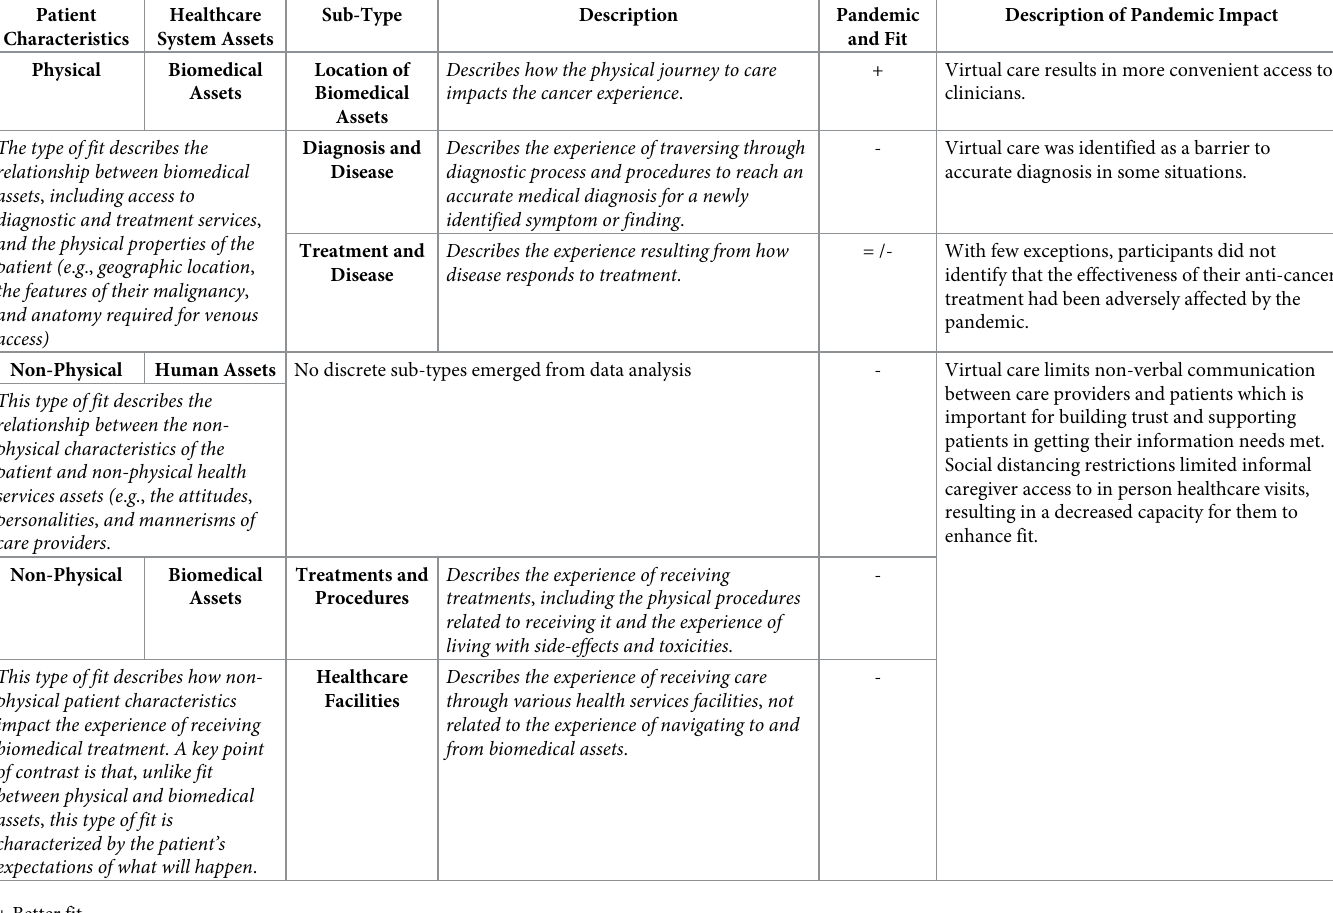
Table 4. Summary of type of fit taxonomy and impact of the